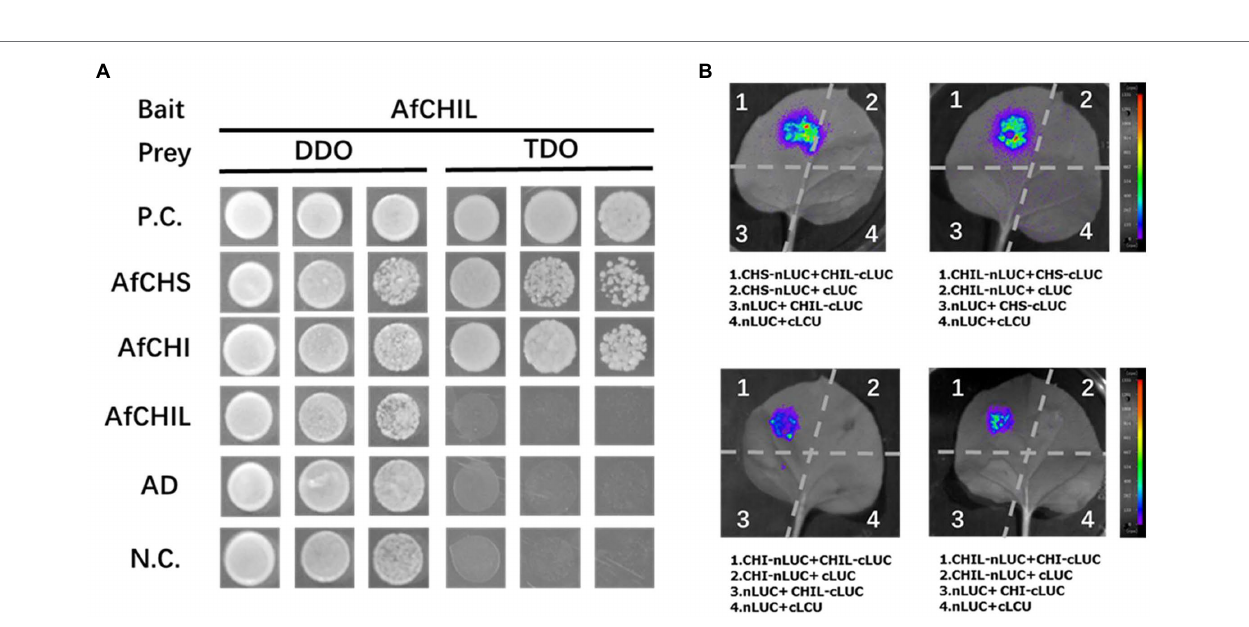
FIGURE 5 | Interaction between AfCHIL, AfCHS, and AfCHI. (A) Yeast two-hybrid experiment demonstrating the protein-protein interaction between AfCHIL, AfCHS, and AfCHI. The TDO medium (SD-Trp-Leu medium) and TDO (SD-Trp-Leu-His medium) medium were used as selective media. P.C. refers to the positive control; N.C. refers to the negative control. (B) Luciferase complementation imaging assay was used for analyzing the protein–protein interaction of AfCHIL, AfCHS, and AfCHI. Agrobacterium tumefaciens carrying different plasmids were infiltrated into Nicotiana benthamiana leaves. Images were recorded at 72 h after